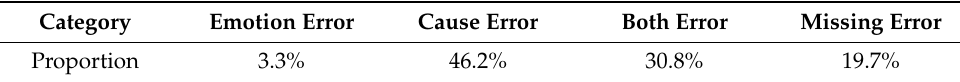
Table 3. The statistics of error emotion-cause